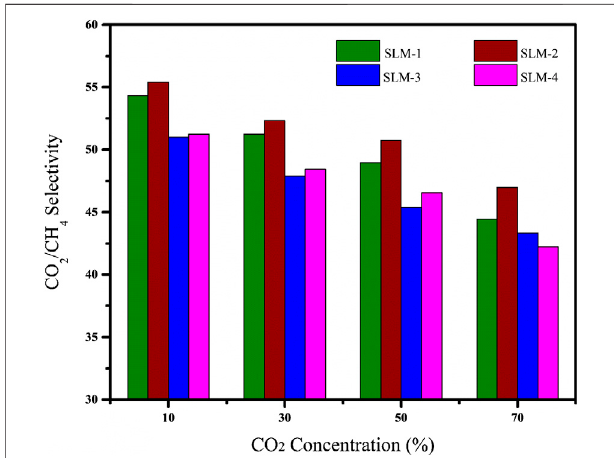
FIGURE 5 | Effect of CO 2 concentration in feed on CO 2 /CH 4